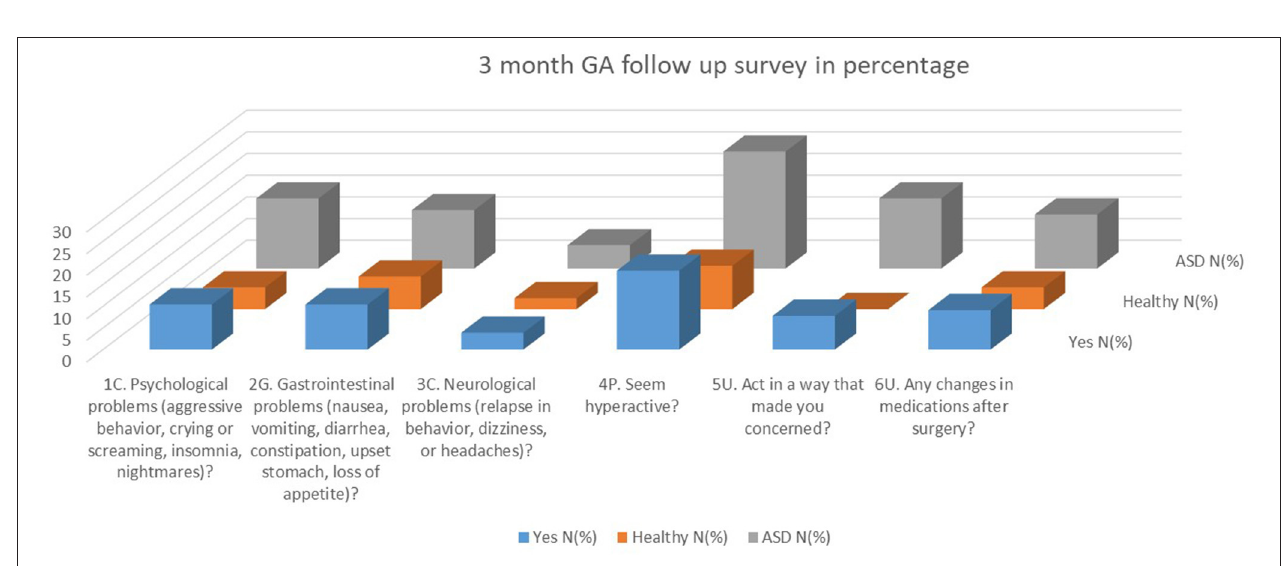
FIGURE 2 | Three months FA follow up in